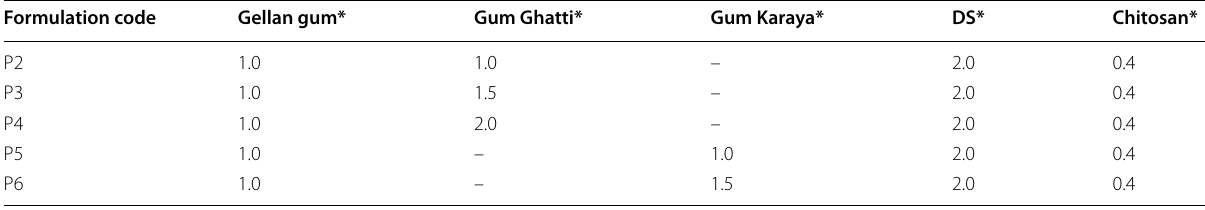
Table 1 Formulation composition of different chitosan-based PEC beads containing Diclofenac sodium along with drug entrapment efficiency and swelling